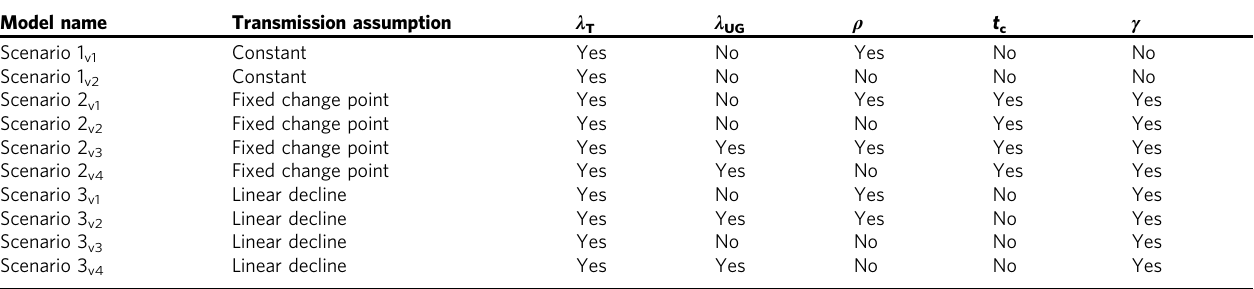
Table 1 De fi nitions of each transmission scenario and the parameters estimated from the data Model name